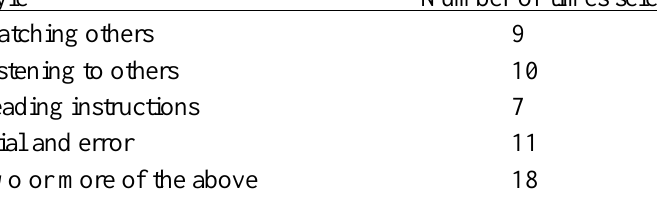
Learning Style Preferences